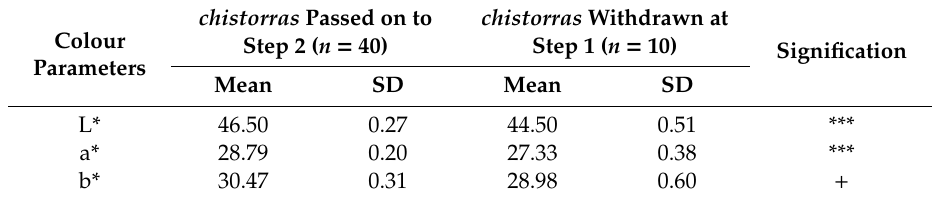
Table 5. Instrumental colour results of chistorras in step 1. Data were grouped in: 40 best scored